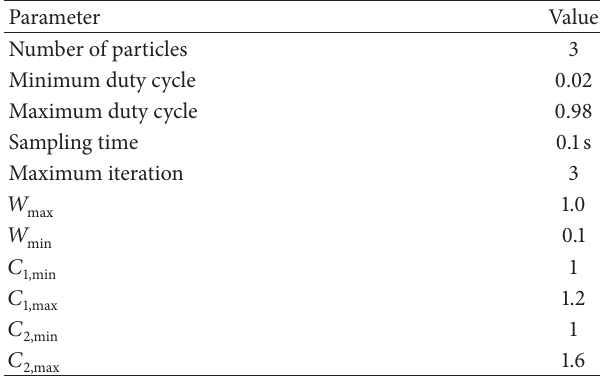
Table 2: Simulation parameter setting of the IPSO-based